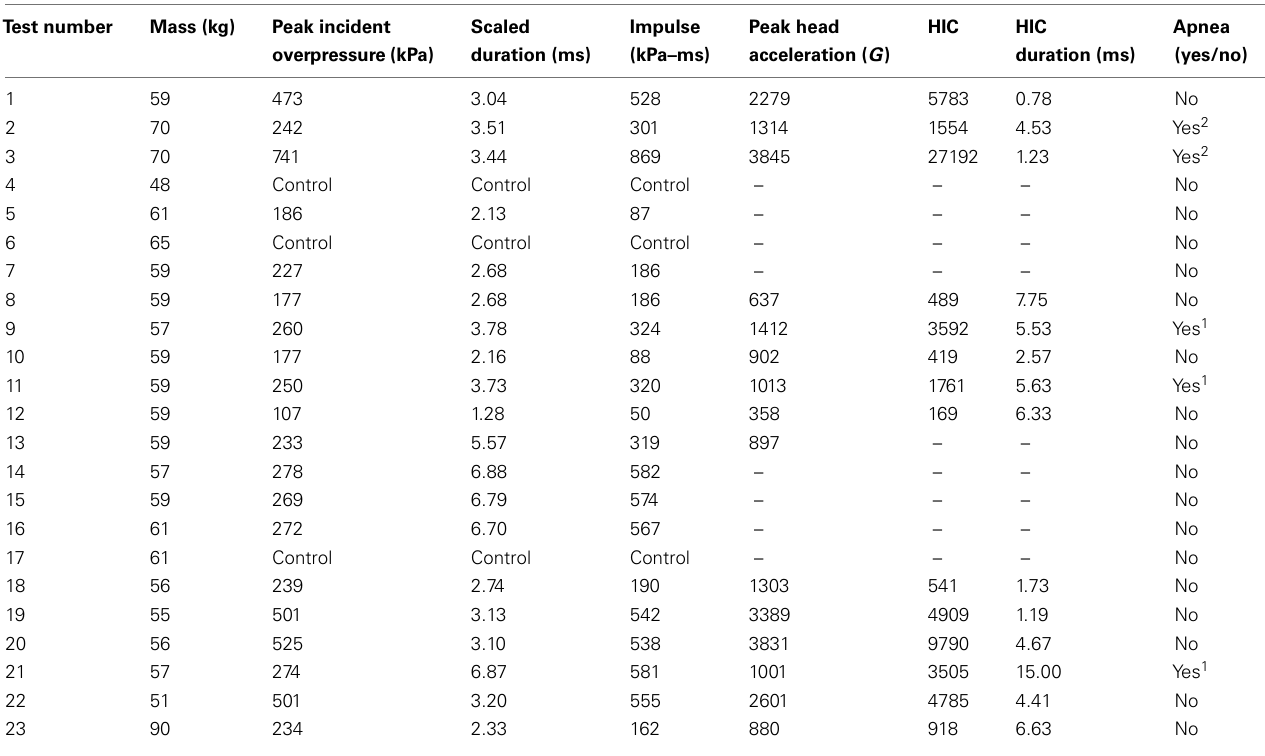
Table 3 | Shock wave test conditions, injury data, and HIC for each animal